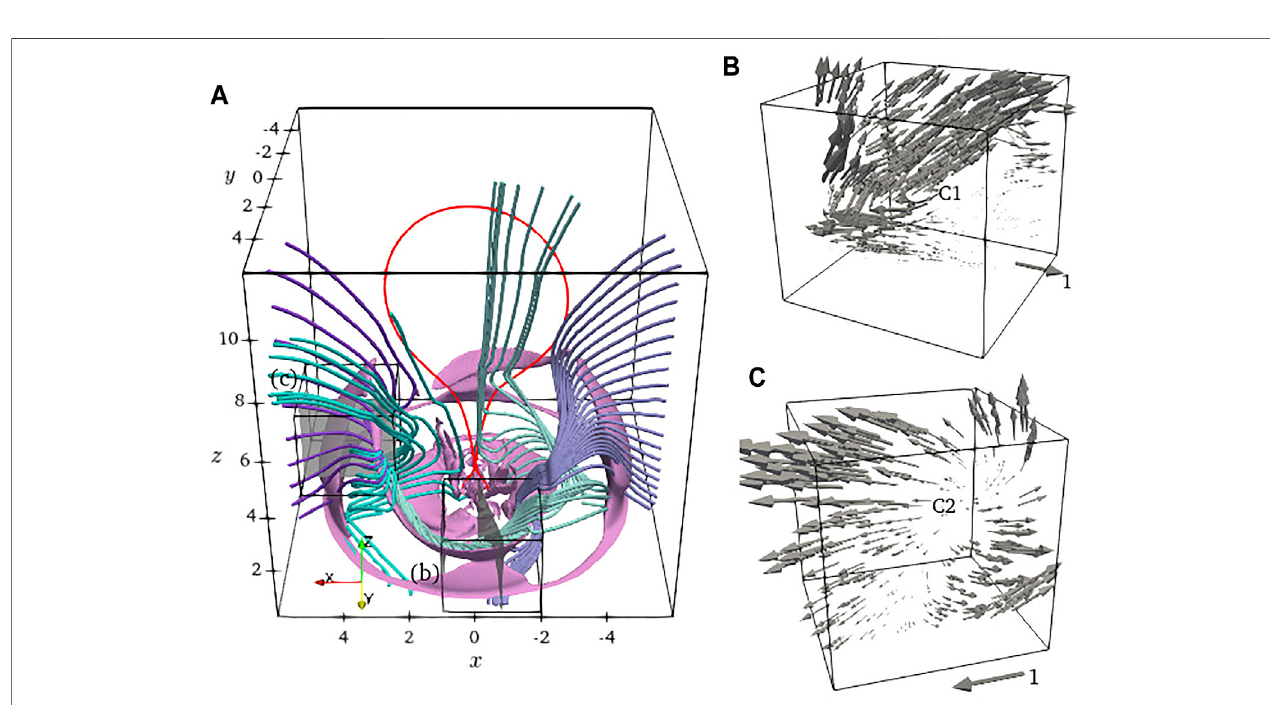
FIGURE4|(A) Velocitystreamlinesin quadrants I(green and purple) and II(light-green and light-purple) ofthe x - y coordinate systemat t (cid:2) 3.The pinksurfacesare velocityiso-surfaceswith | (cid:2) v | (cid:2) 0 . 07,whichindicatesthelocationoftheVS.TheredcurveshowstheCMEbubbleboundary. (B) and (C) Velocity fi eldsongreycutsinside two boxes, which show two types of